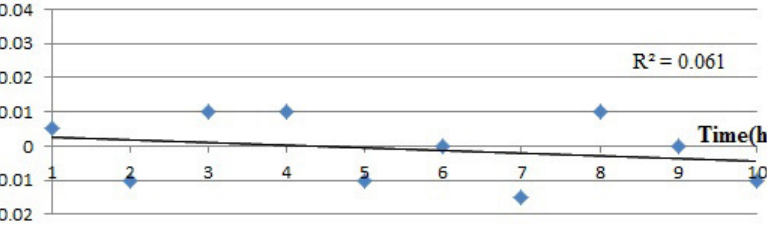
Figure 10. Stability test of the